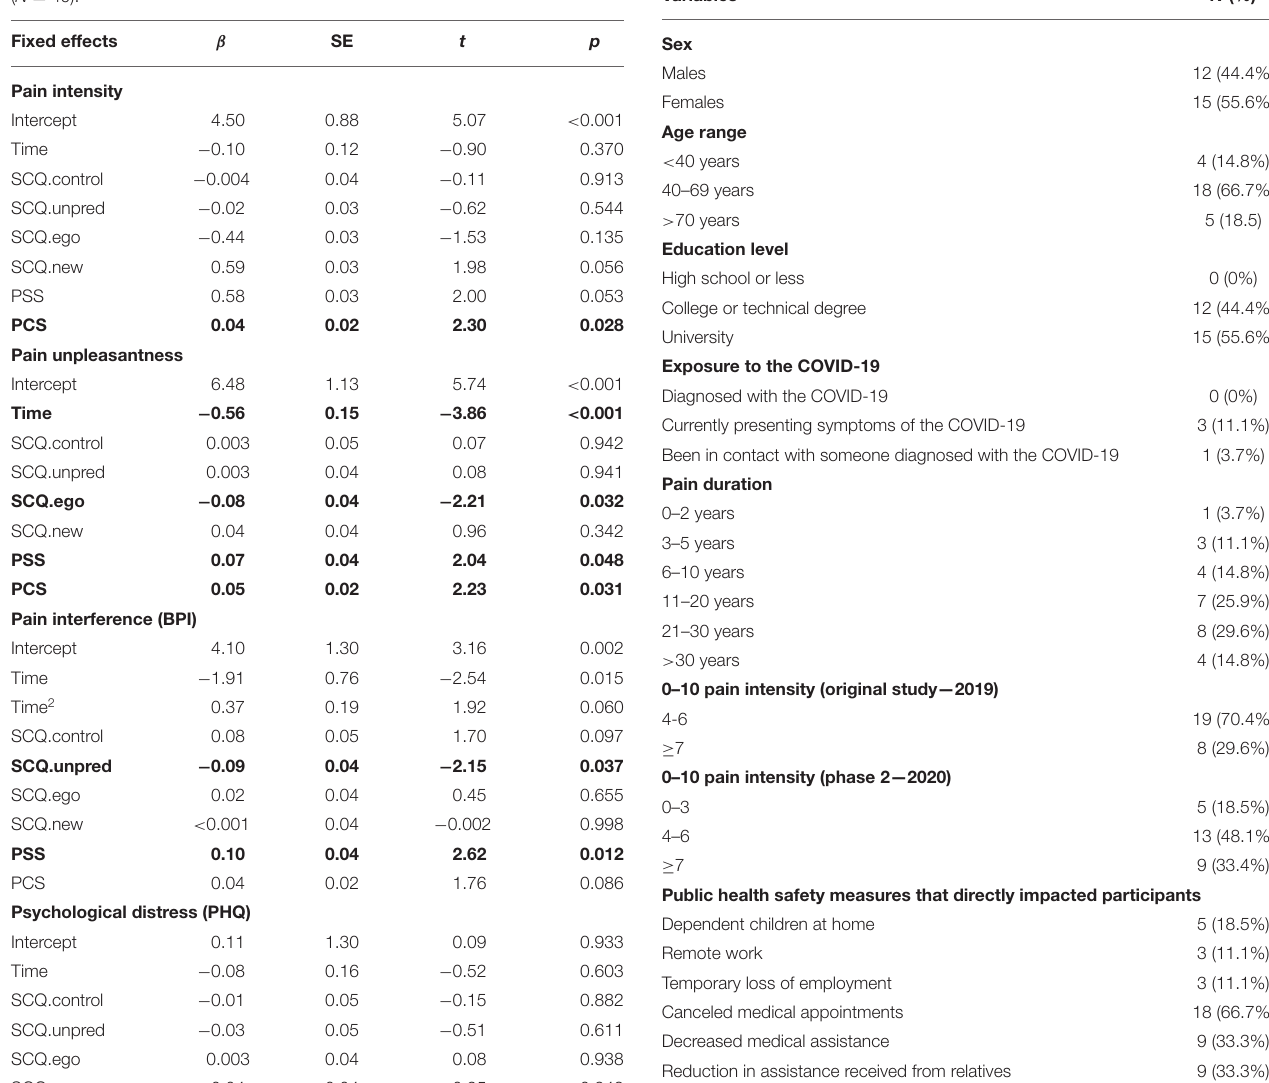
TABLE 3 | Linear mixed effects models examining the within-person evolution of pain and psychological distress taking into account baseline stress characteristics ( N = 49).